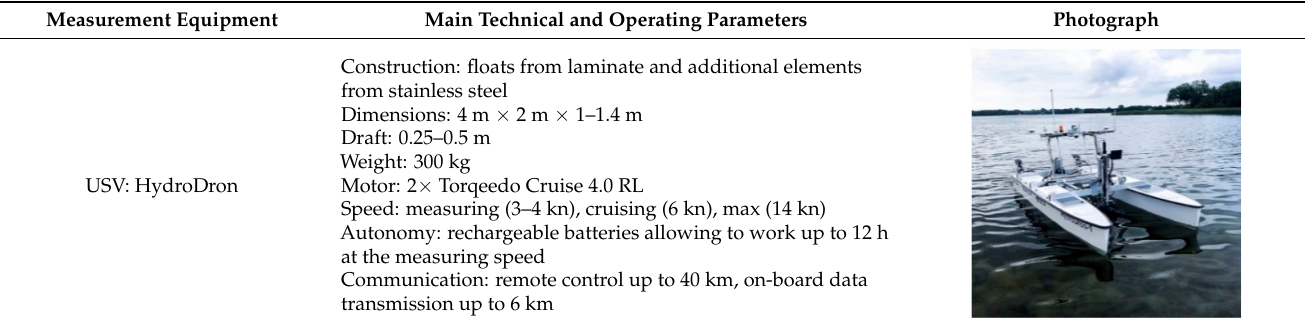
Table A1. Exemplary hardware configuration of the INNOBAT system. Own study based on: [56–61]. Measurement